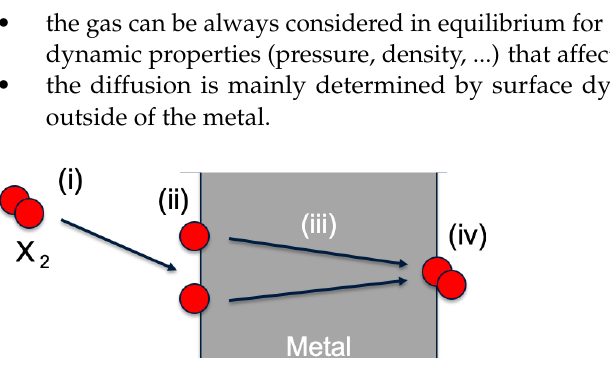
Figure 1. Diagram of the passage of a diatomic gas ( X 2 ) through a generic metal barrier. The process is subdivided in four steps. (i) Free gas expansion, to reach the gas-metal interface (i.e., the metal surface). (ii) Adsorption + Dissociation, at the interface. (iii) Diffusion, through the metallic medium in the direction of lower concentrations. (iv) Recombination + Desorption, at the other gas-metal